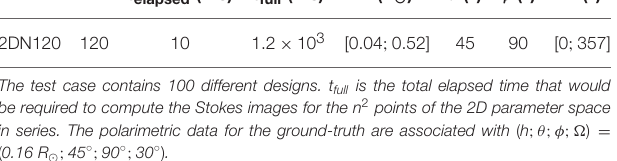
TABLE 3 | Characteristics of the test with a likelihood function possessing multiple maxima.